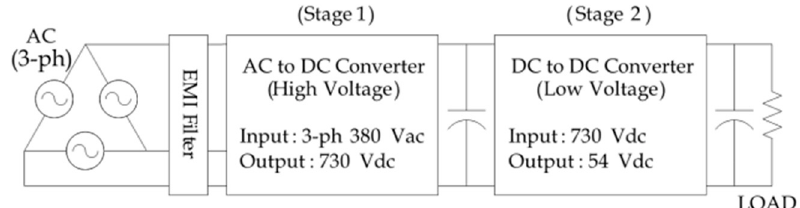
Figure 1. Commonly used configuration of the power-supply system for communications.